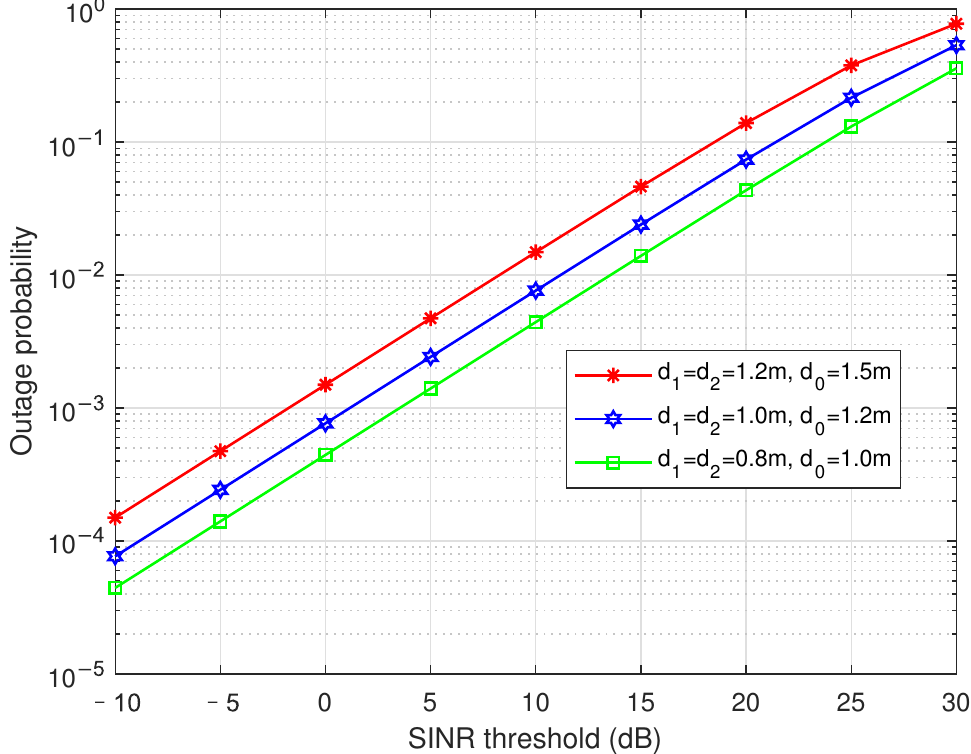
Figure 9. Single node outage probability at different SNR